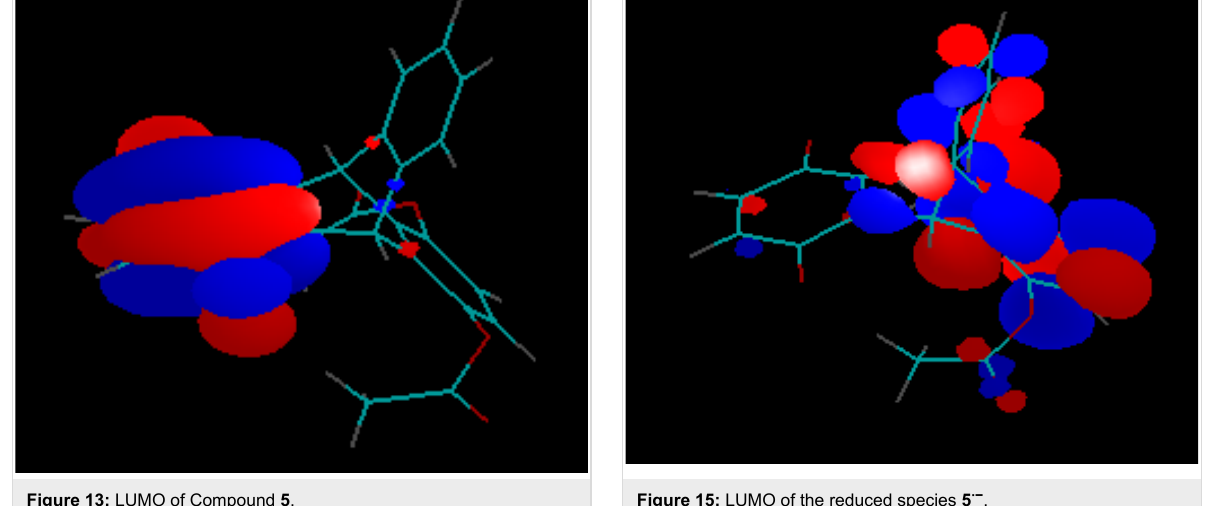
Figure 15: LUMO of the reduced species 5 ·− .